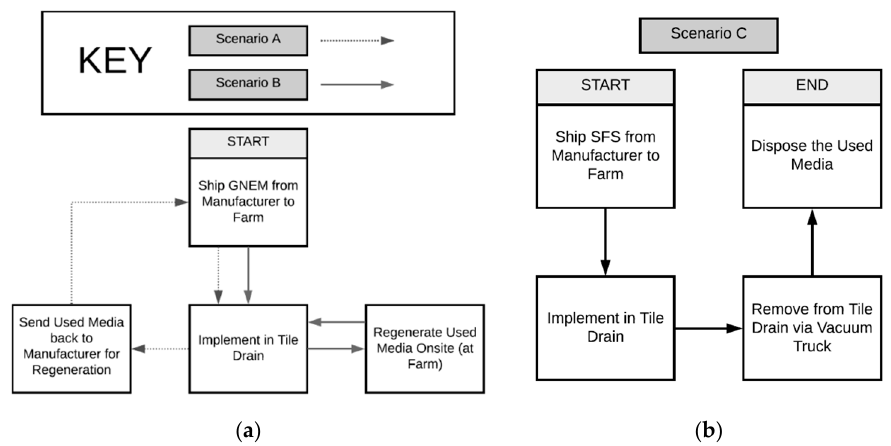
Figure 2. ( a ) Flow diagram for scenarios A and B, and ( b ) flow diagram for scenario C. GNEM: generalized nano-engineered media and SFS: steel furnace slag.